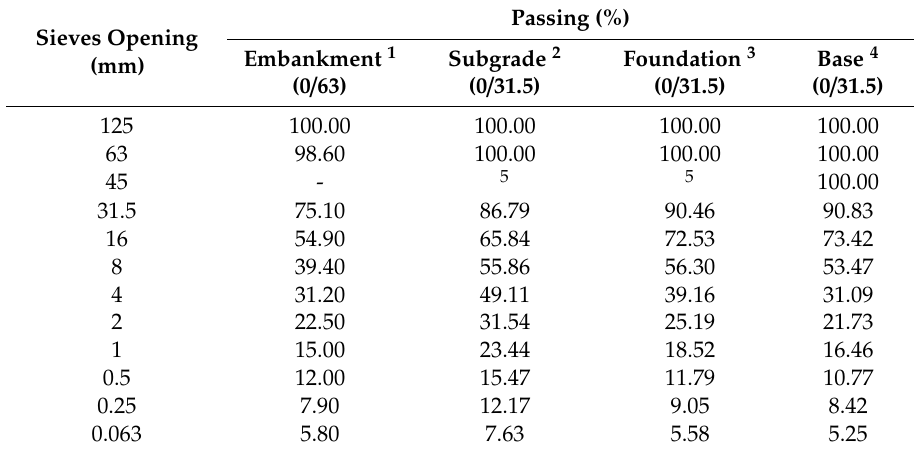
Table 4. Proposed mixtures: particle size distribution and percentage by weight of basic fractions.